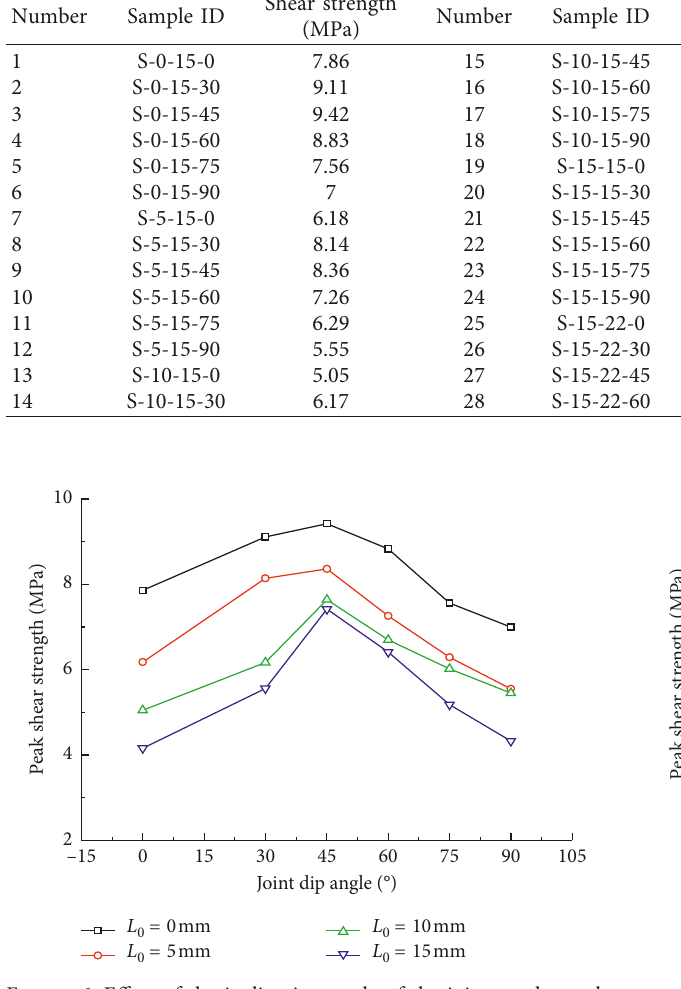
Figure 6: Effect of the inclination angle of the joint on the peak shear strength. Figure 7: Effect of the joint overlap on the peak shear strength.